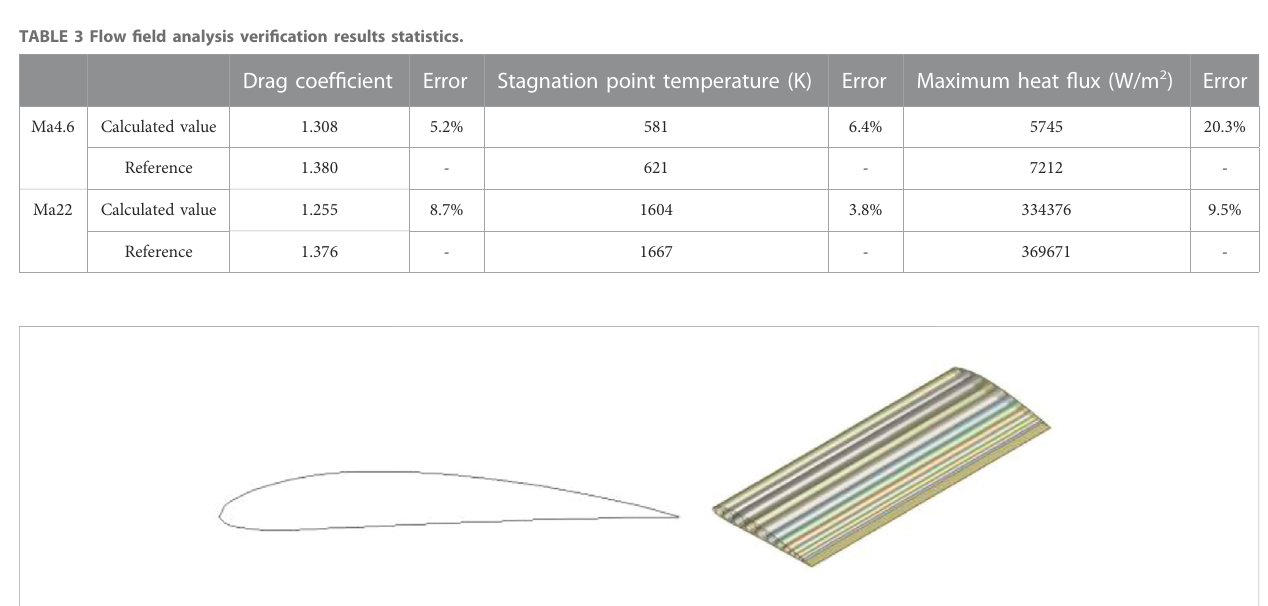
FIGURE 5 NACA4412 airfoil section and 3D model schematic